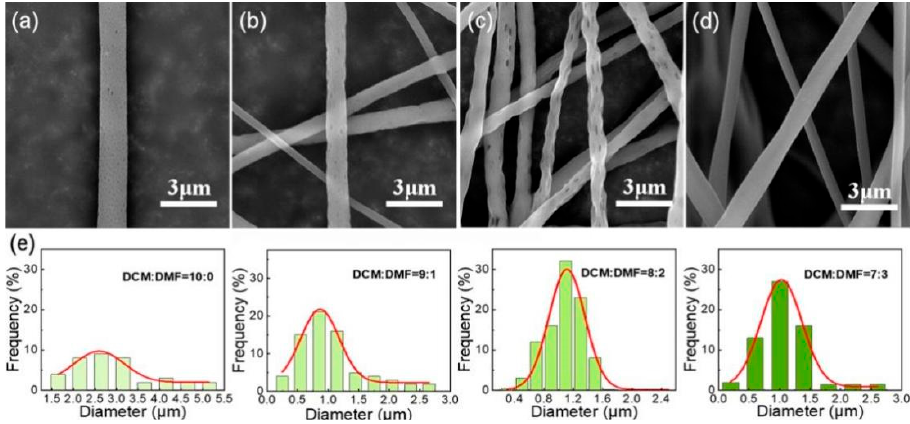
Figure 3. SEM images of the electrospun fibrous membrane with different solvent ratios, ( a ) DCM:DMF = 10:0; ( b ) DCM:DMF = 9:1; ( c ) DCM:DMF = 8:2; ( d ) DCM:DMF = 7:3; ( e ) Gaussian